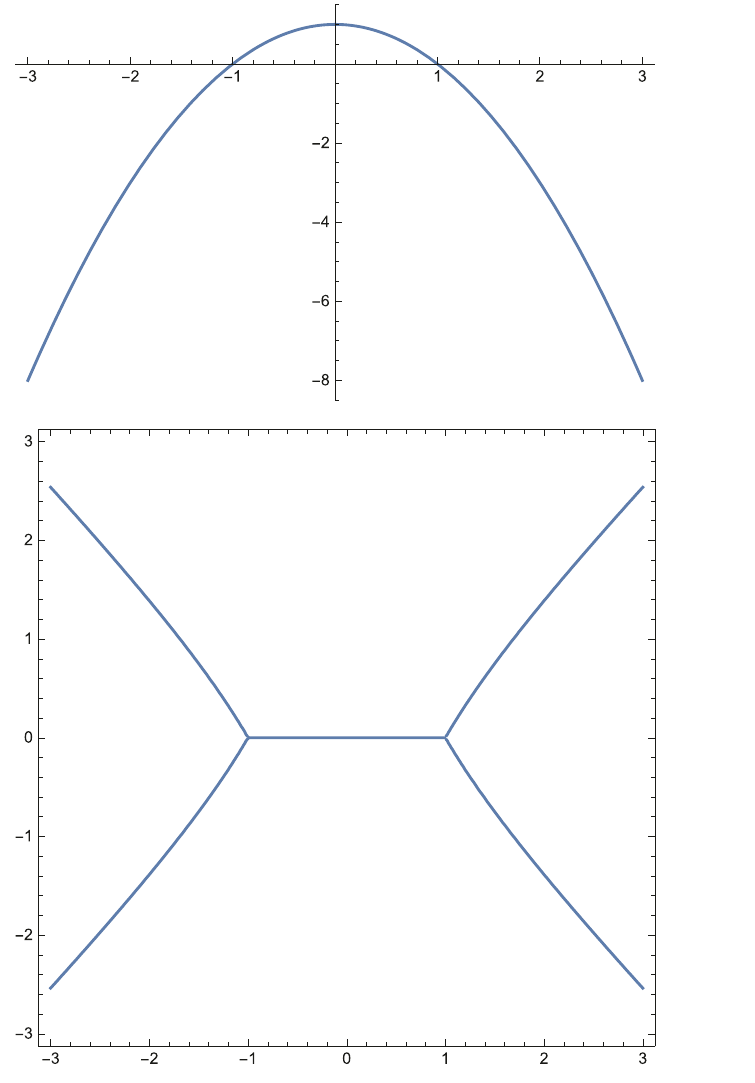
Figure 1 . The potential and the Stokes lines are shown for E < 0 . In this picture, χ is tachyonic within − 1 < x < 1 . The classical turning points are appearing at x = ± 1